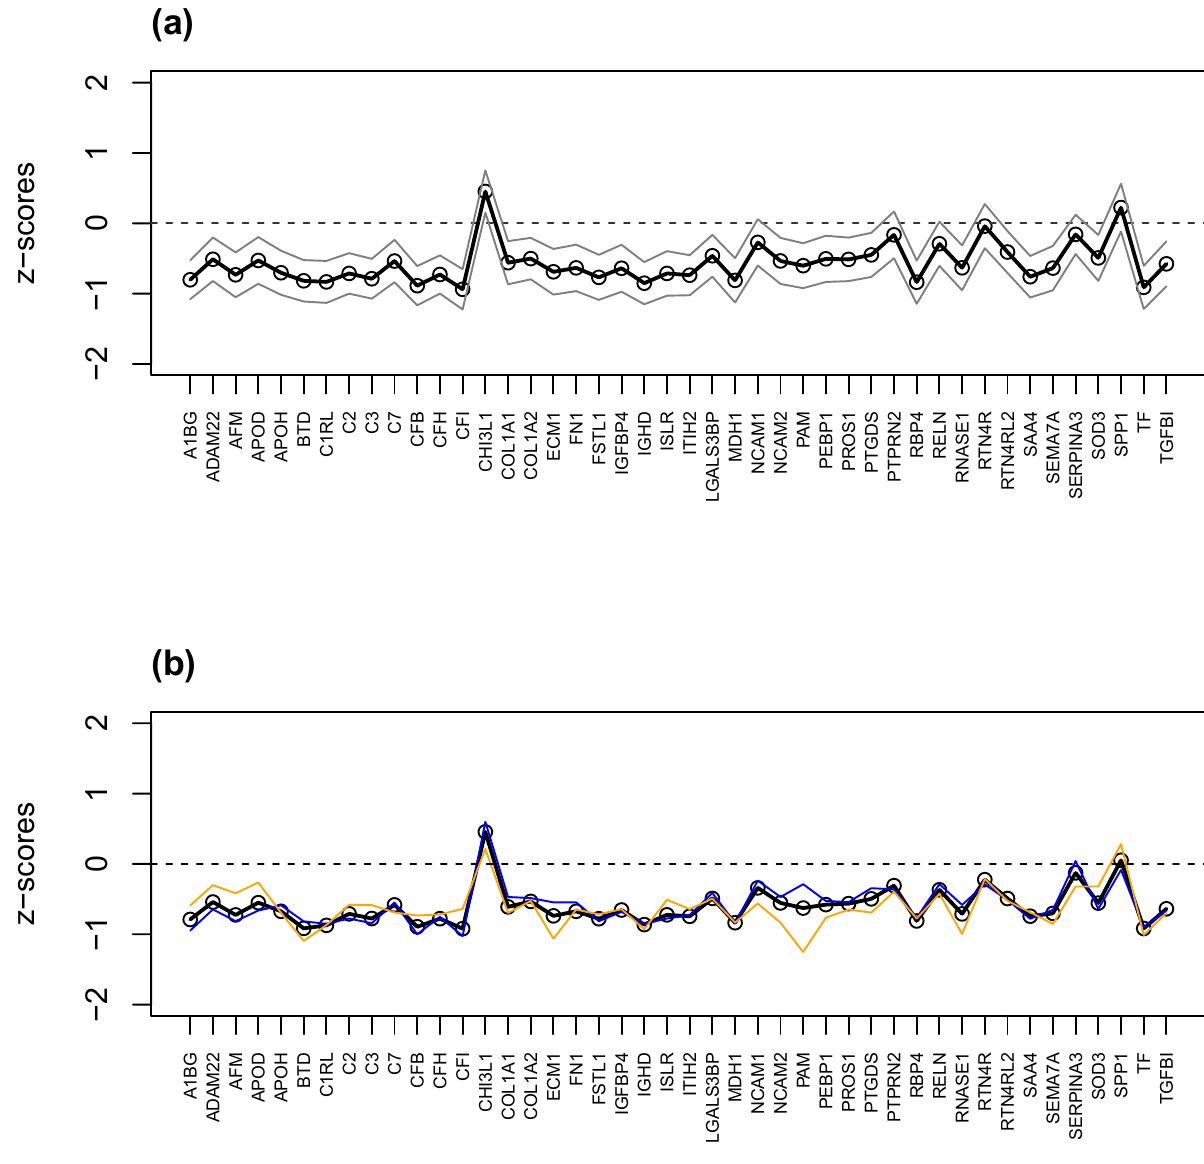
Figure 5. Cohort 1 and 2. ( a ) Confidence intervals (95%) of proteins selected by Martens’ uncertainly test in PLS-DA of the data from both cohorts. Confidence intervals are made on the merged data where the data table of ER values of MS status from cohort 1 are combined with the data of group A of cohort 2 into a single table of 163 individuals. The thick lines are the means, and the grey lines are the confidence borders. ( b ) Means of females (orange) and males (blue) and means of all (black). The protein names are provided in Supplementary Table S2 and